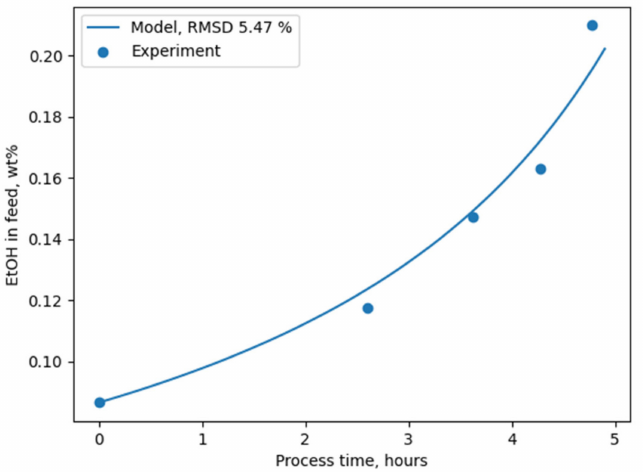
Figure 6. Comparison of the modelling results (curve) and experimental data (dots) regarding the isothermal water/ethanol mixture concentration at 68.8 ◦ C with Romakon-PM 102